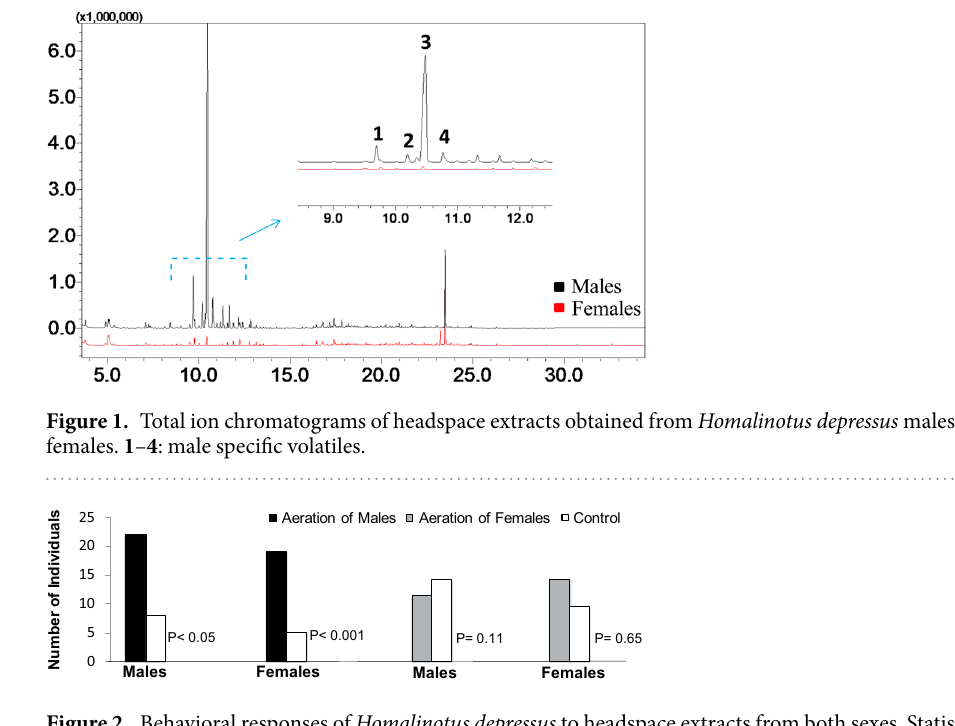
Figure 2. Behavioral responses of Homalinotus depressus to headspace extracts from both sexes. Statistical difference calculated according to binomial distribution test (p < 0.05,